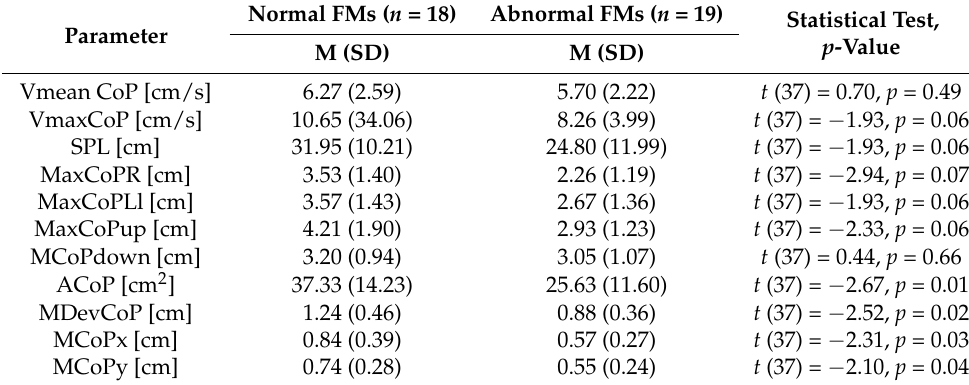
Table 4. Differences in CoP parameters describing the spontaneous sway of CoP and the area of CoP between the groups of infants who presented with normal and abnormal FMs in PT in the prone